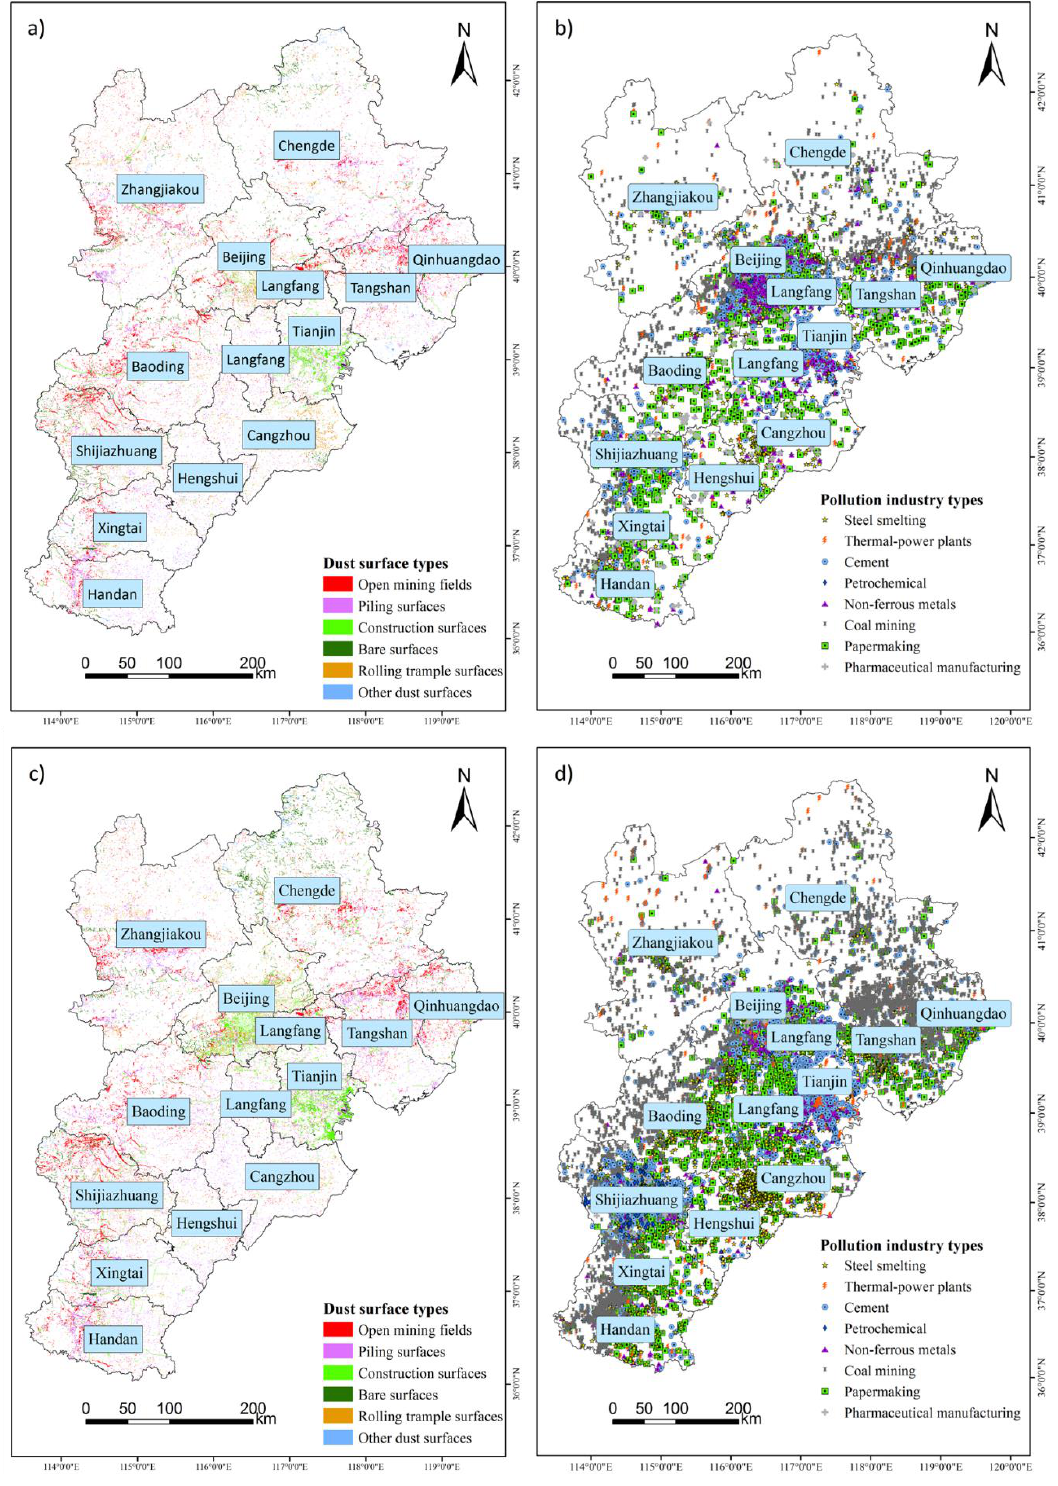
Figure 3. Distribution patterns of dust surfaces and pollution industries in BTH: ( a ) distribution of dust surface in 2007; ( b ) distribution of pollution industries in 2007; ( c ) distribution of dust surface in 2013; and ( d ) distribution of pollution industries in 2013.